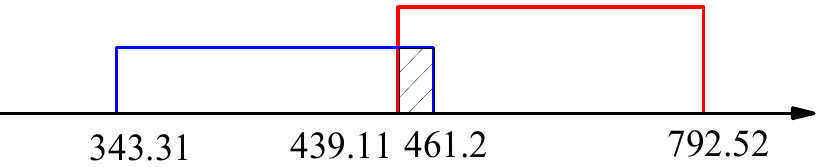
Figure 6. Comparison of stress due to dynamic loading at breaking and ultimate tensile strength at the interval (unit: MPa).